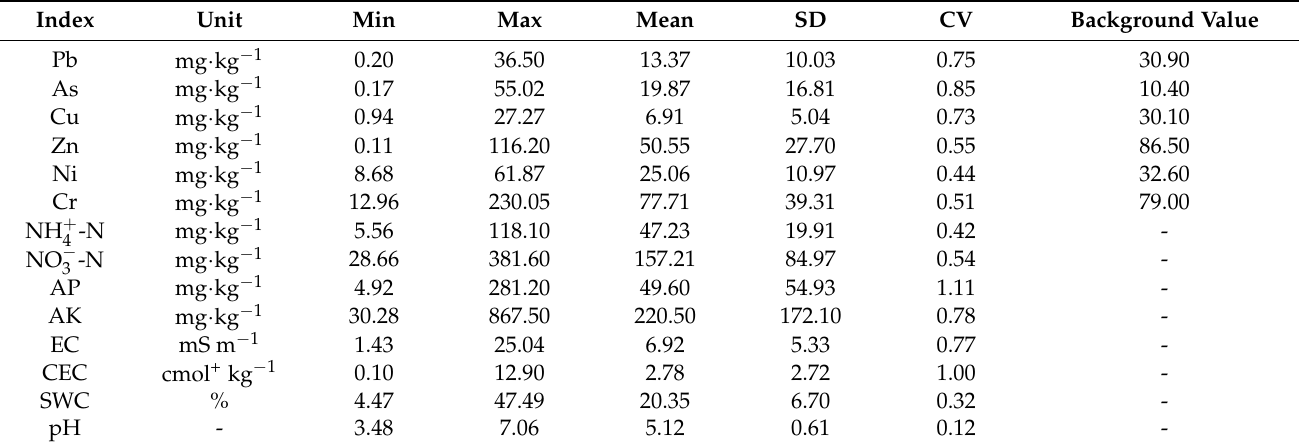
Table 1. Descriptive statistics for heavy metal concentrations and basic parameters in